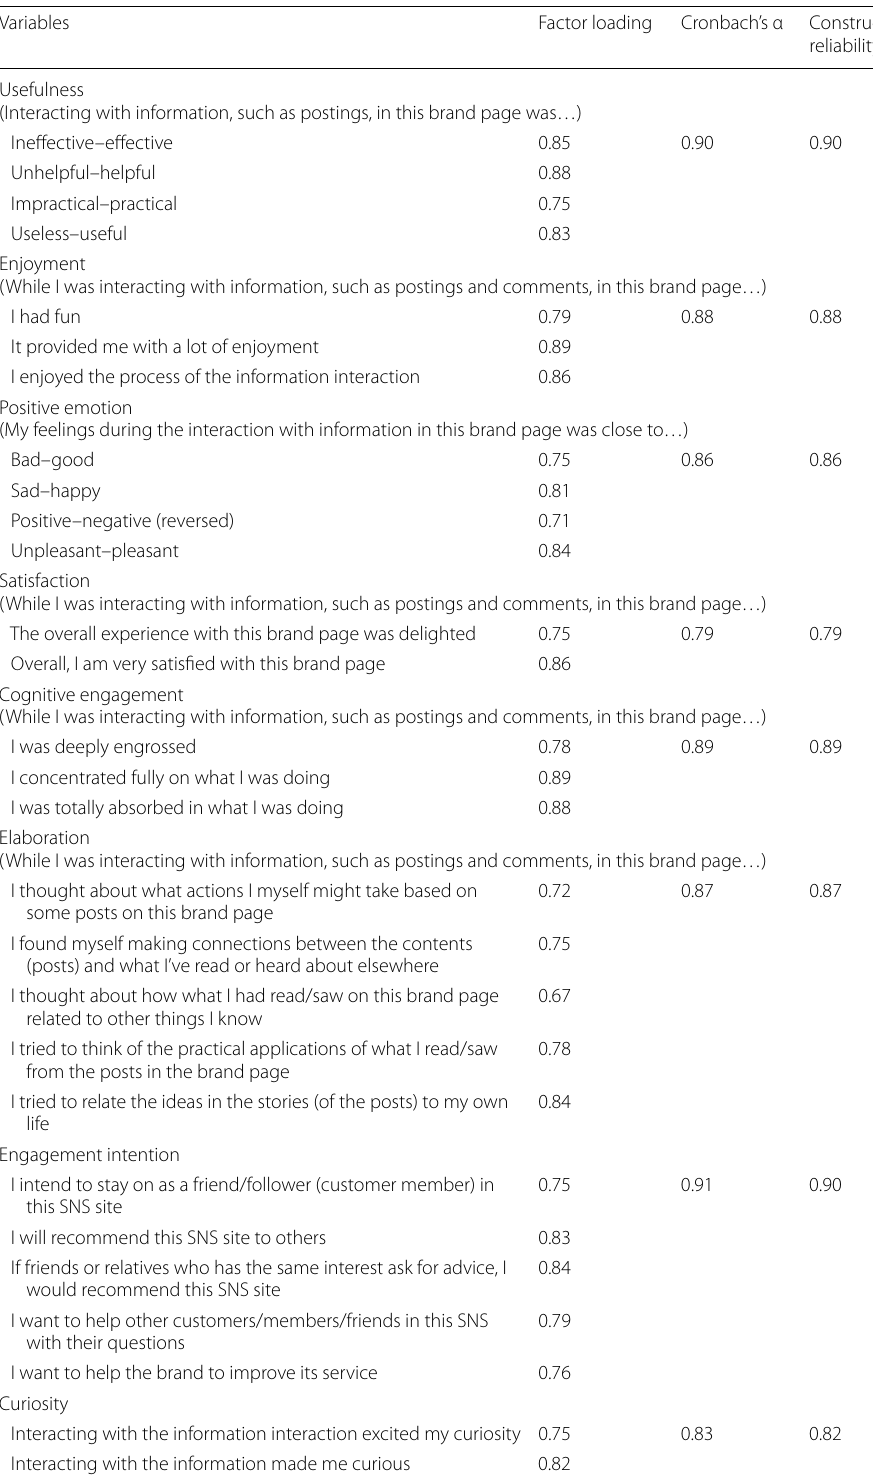
Table 2 Measurement model assessment